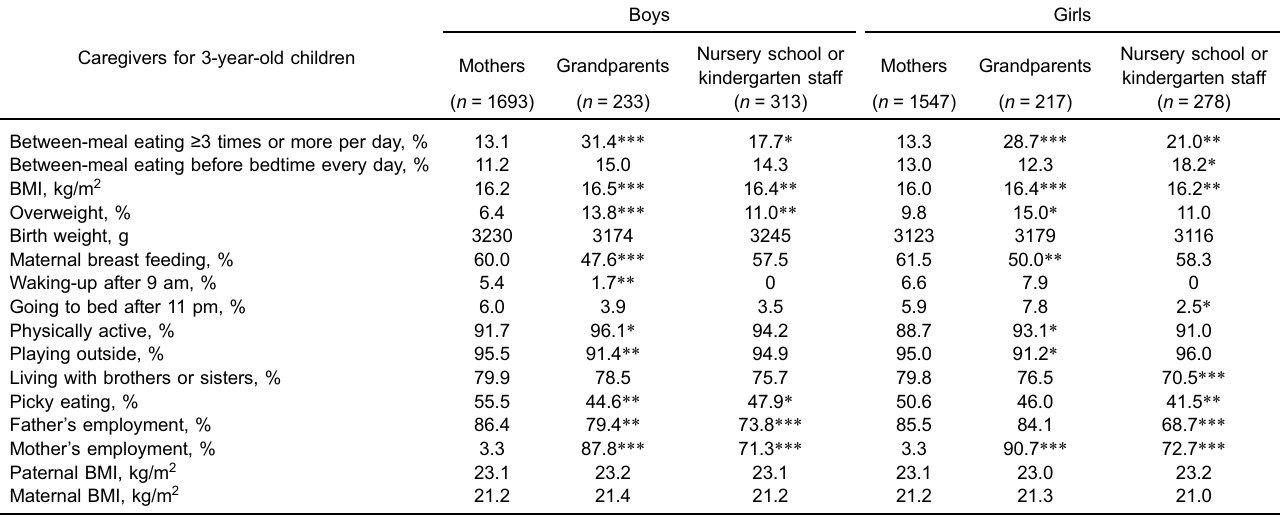
Table 1. Sex-speci fi c mean values and proportion of baseline characteristics at age 3 among 2239 boys and 2042 girls, IBACHIL, 1989